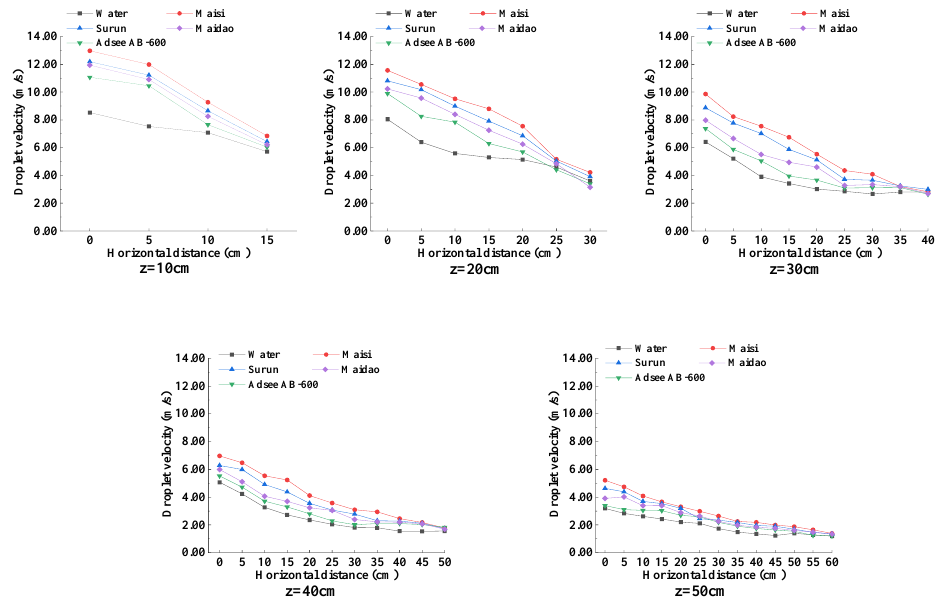
Figure 10. Distribution of droplets velocity V X on X -axis with different adjuvants. The distribution of droplet velocity V X on the X -axis by nozzle type is shown in Figure 11. the droplet velocity V X on X -axis of three nozzles decreases with the increase of X -axis distance in horizontal direction. AD120-03 nozzle droplet velocity is the largest, LU120-03 followed, IDK120-03 is the smallest.